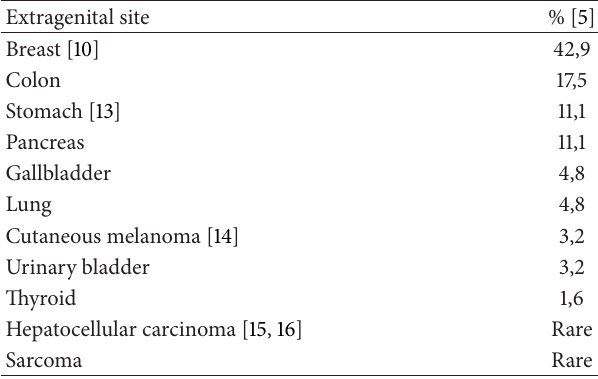
Table2:Extragenitalprimarytumorsmostfrequentlymetastasising to the uterine corpus.